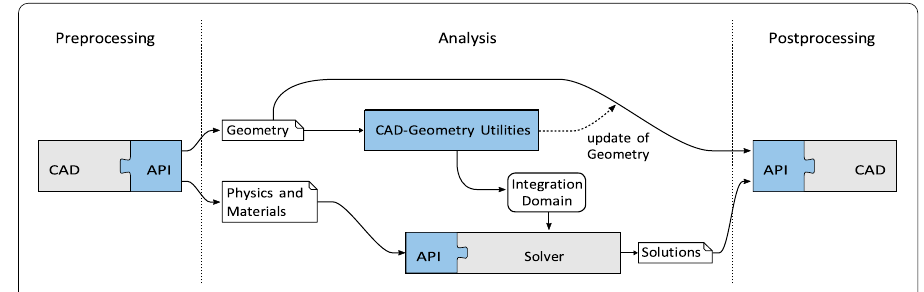
Fig. 10 Exchange files and processes for an IBRA design-through-analysis workflow. The data in Geometry and Integrationdomain can be handled with the proposed IBRA exchange format. The PhysicsandMaterials file is solver specific whereas the Solutiondata file still requires an appropriate data format. The missing functionalities within CAD systems and FE solvers are added through corresponding applicationprogramming interfaces